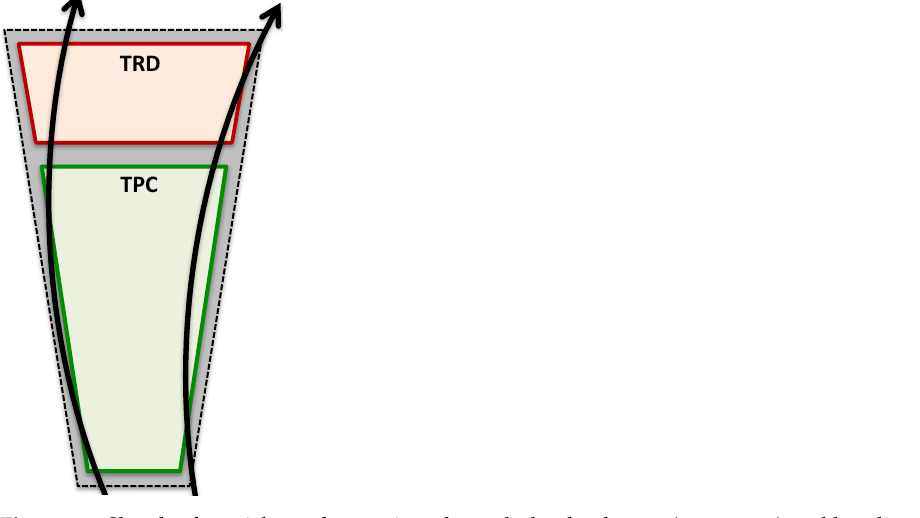
Figure 12. Sketch of particle tracks passing through the dead-zone (gray area) and bending inside or outside the active